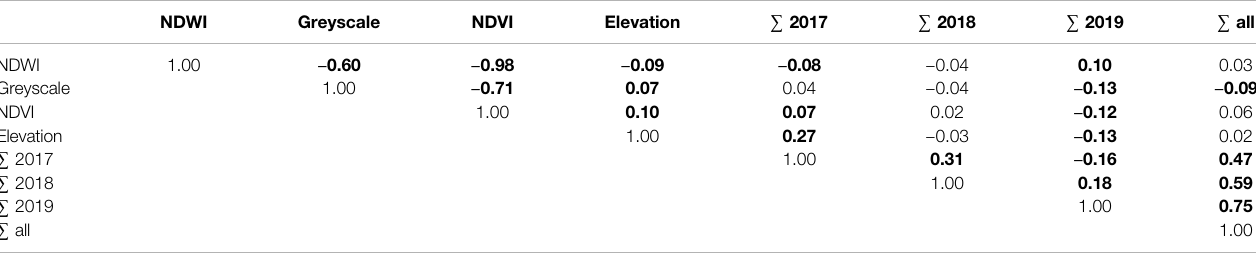
TABLE 2 | Pearson correlation coef fi cients of yearly InSAR surface displacement sums and quantitative data derived from the Worldview 2015 image and ALOS DEM. Bold numbers are signi fi cantly strong correlations ( p < 0.01). NDWI Greyscale NDVI Elevation